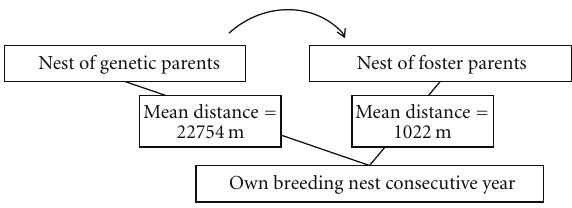
Figure 5: Yearling birds recruited from cross-fostering experiments between pied and collared flycatchers on the Swedish island of ¨Oland 2002–2009 subsequently settled to breed significantly closer to their foster parents than to their genetic